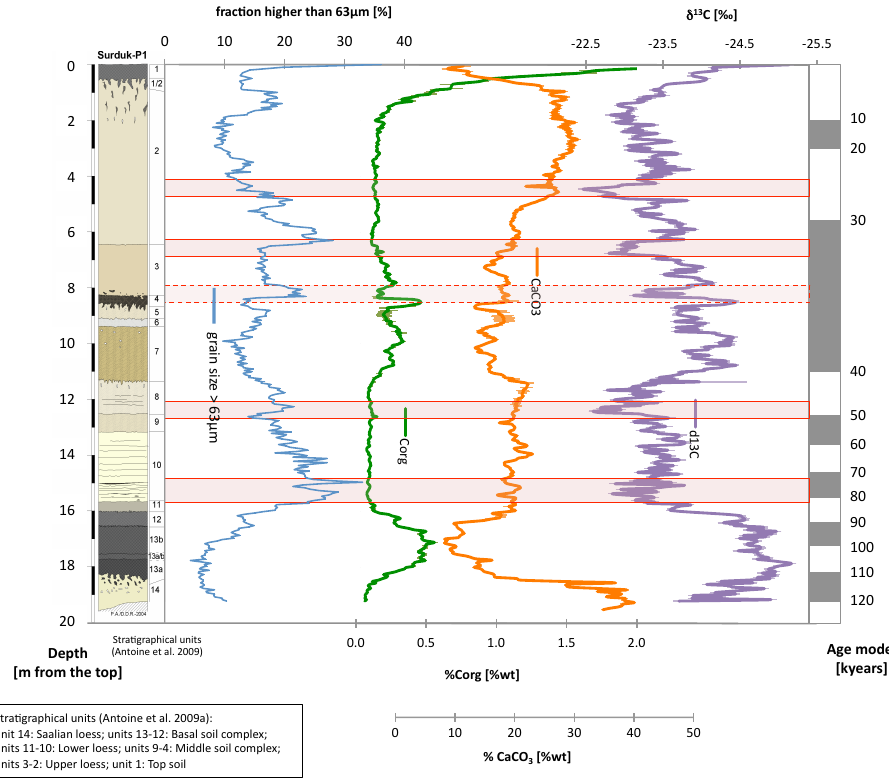
Fig. 4. Geochemical data of the Surduk loess sequence. The stratigraphical description is from Antoine et al. (2009a). Blue, green, orange and violet curves represent grain sizes greater than 63µm in %, organic carbon content in %wt, carbonate content in %wt and δ 13 C of loess organic matter in ‰ vs. PDB, respectively. All data are presented versus depth. On the right axis, a non-linear timescale is presented based on IRSL and 14 C dates. Horizontal bars highlight C 4 episodes. Major stratigraphic units are 14: Saalian loess; 13–12: basal soil complex; 11–10: lower loess; 9–4: middle soil complex; 3–2: upper loess; and 1: top soil (Antoine et al.,